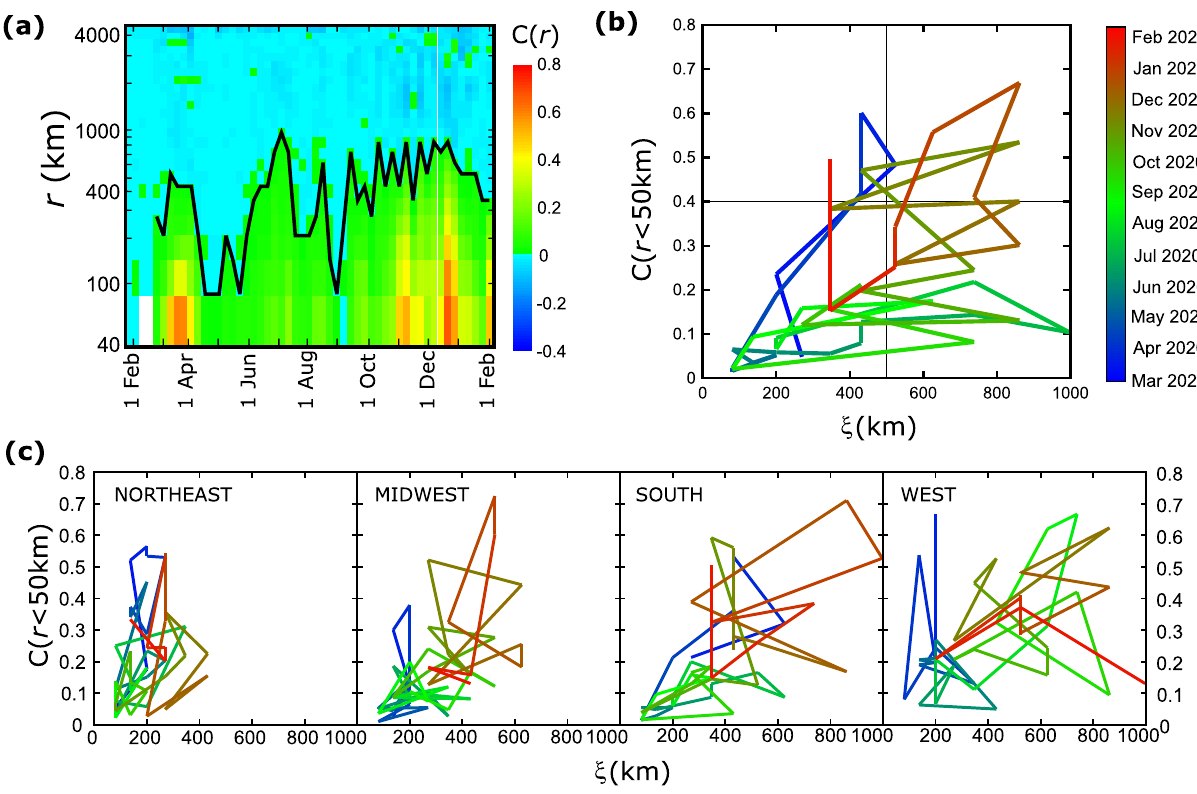
Figure 3. Time evolution of the correlation function. ( a ) The value of the correlation function is shown as a function of the date (x-axis) and distance (y-axis). Red and green colors correspond to positive values while blue colors indicate negative values. The line that separates the two regimes describes the correlation length as a function of time. ( b ) The ‘trajectory’ of the epidemic is plotted by the values of local correlations C(r < 50 km) vs the correlation length, ξ, at different times for the entire country. ( c ) Same trajectory plots as in ( b ) for the four regions of